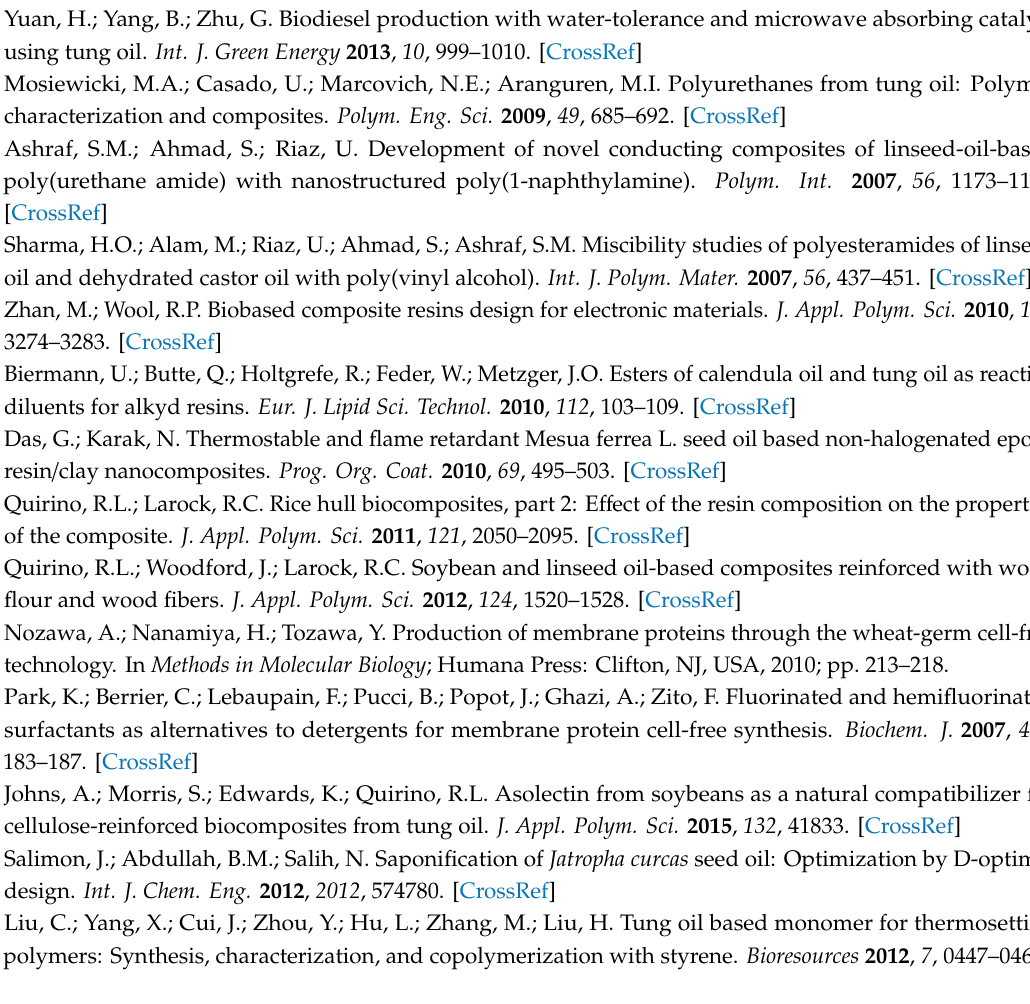
Figure S1: Reaction mechanism for the free radical polymerization of α -eleostearic acid with di- tert butyl peroxide (DTBP) as the free radical initiator, Figure S2: General schematic for the preparation of thermosetting